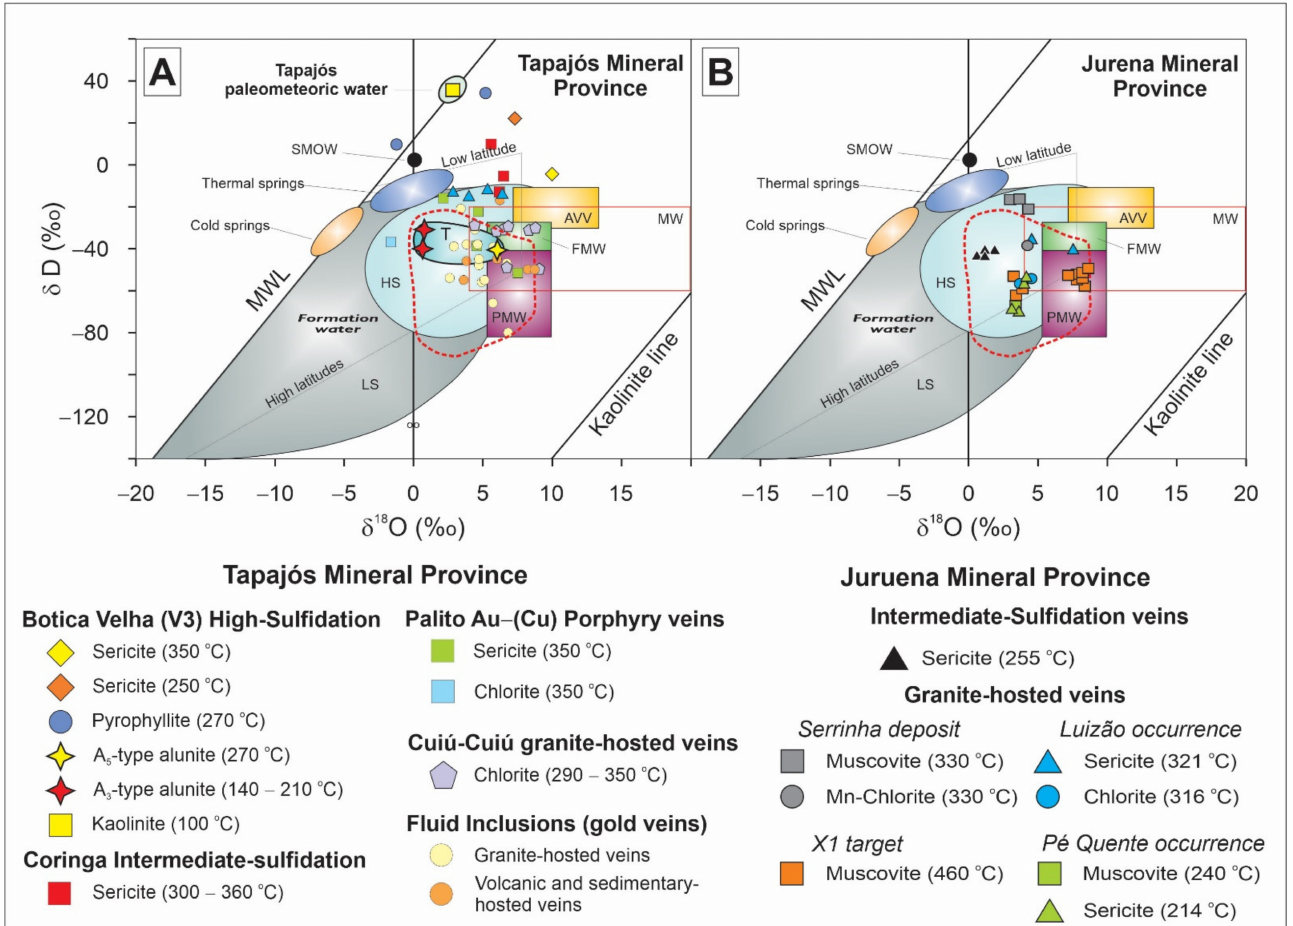
Figure 5. Calculated oxygen and hydrogen isotope composition of the hydrothermal fluids in equilibrium with minerals representative of the magmatic–hydrothermal deposits and prospects in the TMP ( A ) and JMP ( B ). Alunite field based on [93]; PMW = primary magmatic water [94]; VW = volcanic water [95]; epithermal deposit fluids [96,97] cold and thermal springs [98]. The dashed red line discriminates potassic (inside the magmatic water field) and sericitic (outside the magmatic water field) alteration of porphyry mineralization [99]. HS = Field of high-sulfidation hydrothermal fluids; LS = Low-sulfidation fluids, and T = Alunite of the 1.87 Ga Tapaj ó s high-sulfidation fluid. Data source: [this paper and